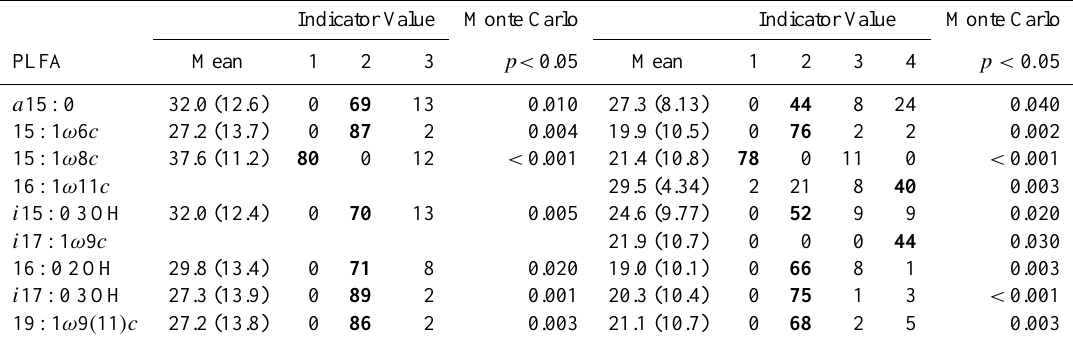
Table 4. PLFA indicator species analysis associated with site groups. Each value represents the mean indicator with standard deviation in parentheses, and the highest indicator value is in bold. Only PLFAs that were found to be significantly different among groups are presented. The left side of the table shows comparison among natural ecosites (Groups 1, 2, and 3), while the right side shows comparison among all